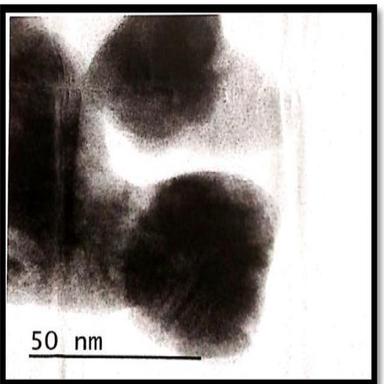
TEM Analysis of aluminum oxide nanoparticles.